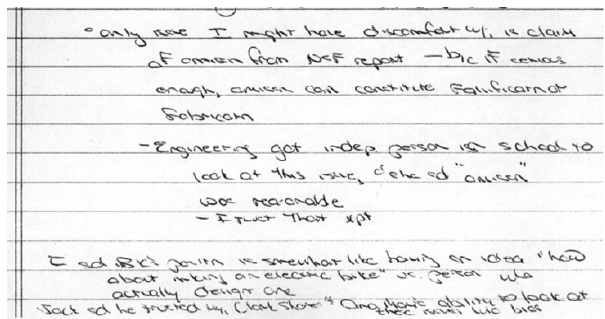
Figure 11: Fragment of a page of written notes by Director of the Office of Scholarly Integrity, Anne Ackenhusen: “only issue I might have discomfort w/ is claim of omission from NSF report - b/c if serious enough, omission can constitute falsification or fabrication.